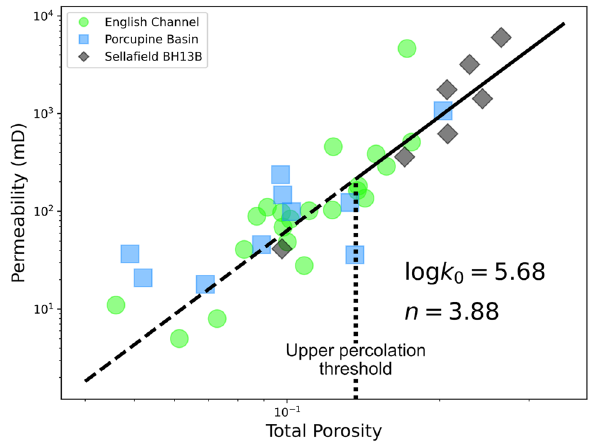
Figure 4. Porosity–permeability relationship plot on log axes, showing data from all sample suites. It is clear that the bulk of data points are found at > 10% total porosity, above the region of the upper percolation threshold. This results in a well characterised relationship in this region, leaving a more poorly defined range from 0 to 10% which requires further investigation. The vertical black broken line represents the 14% upper percolation threshold. The sloping black fit line is calculated using the fit parameters shown on the plot to 5.68 φ 3.88 provide a relationship given by, K = 10 . The solid part of the fit line represents the data range above the upper percolation threshold where this relationship is well constrained. The dashed part of the fit line represents the range below the upper percolation threshold where this fit becomes limited in its